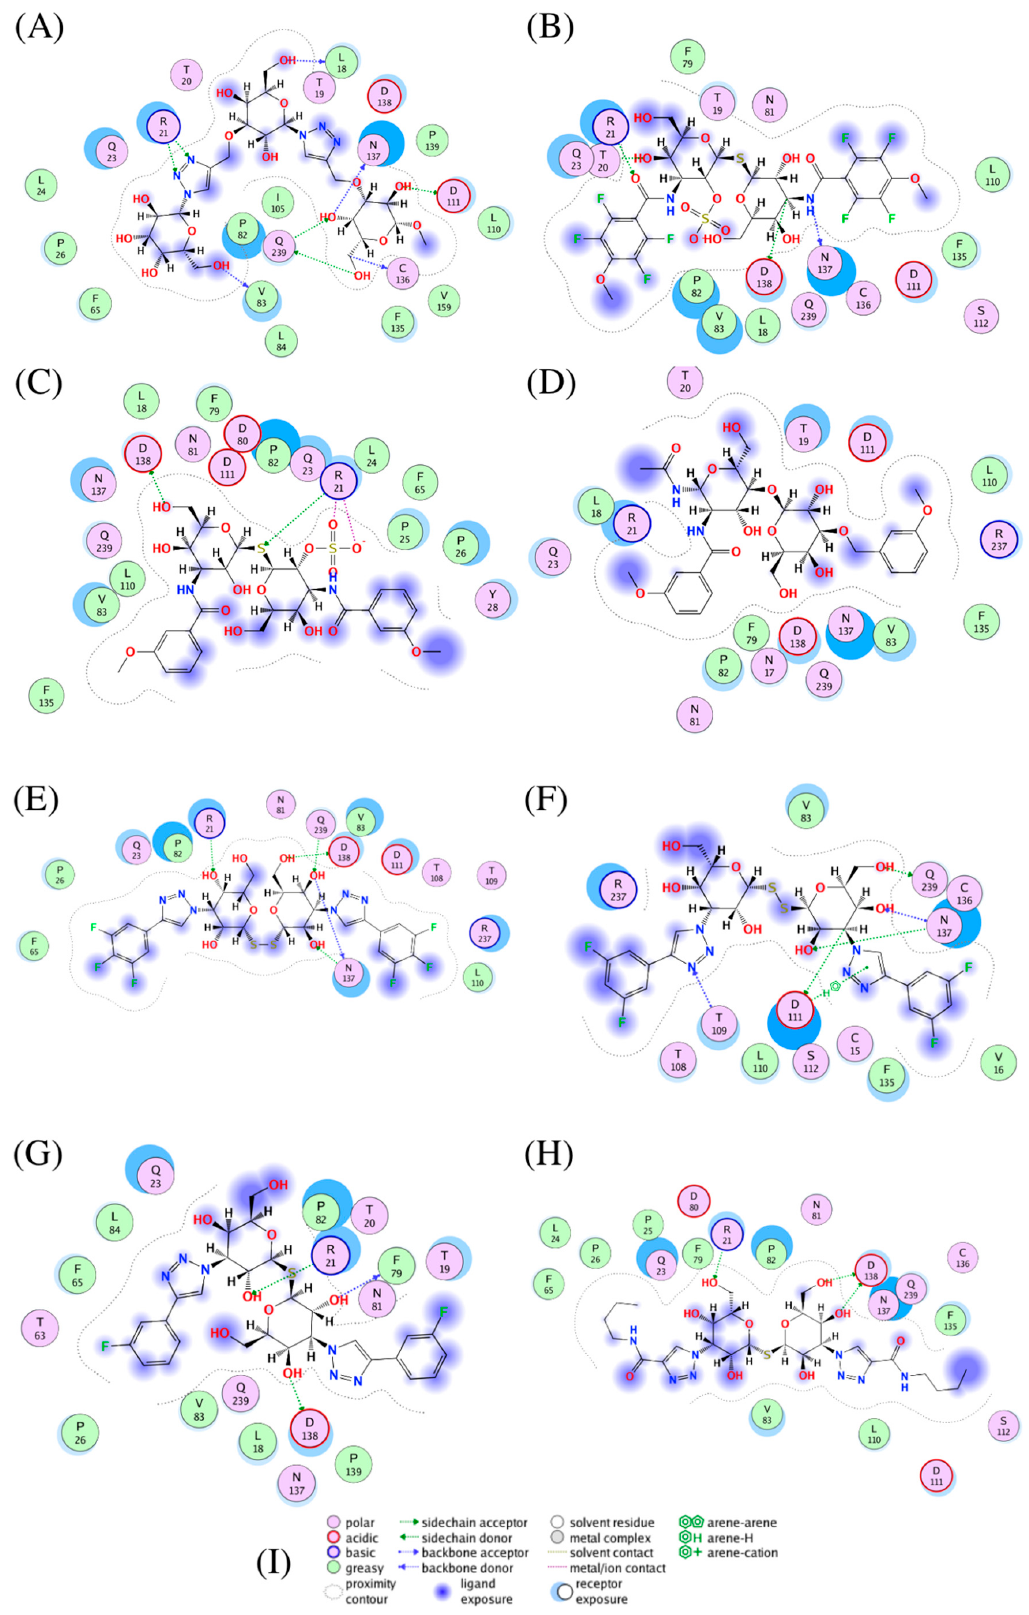
Figure 8. Interaction plots of five top Spike protein inhibitors. ( A ) P8G, ( B ) A6J, ( C ) GMK, ( D ) 8VT, ( E ) NEW7, ( F ) NEW8, ( G ) TD2 and ( H ) NEW5. A graphical key ( I ) is included to help interpret the 2-D part of the ligand interactions